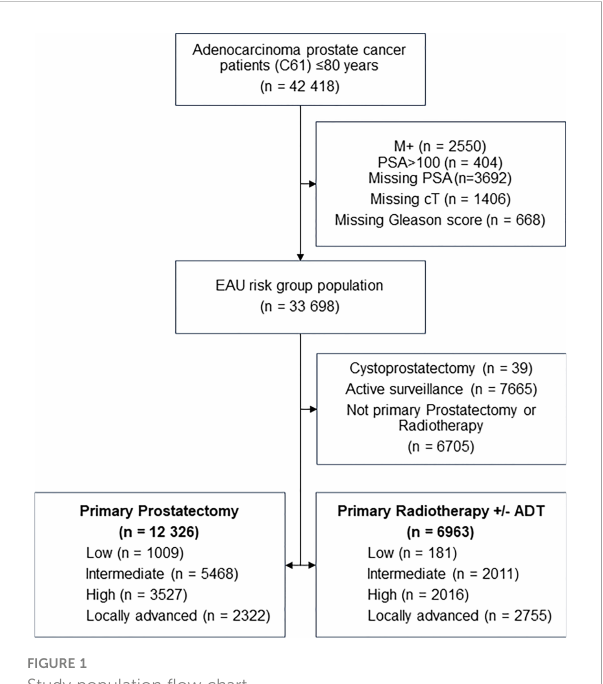
FIGURE 1 Study population fl ow